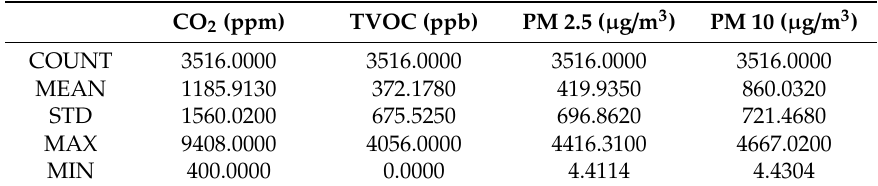
Table 4. Data change depending on the situation.